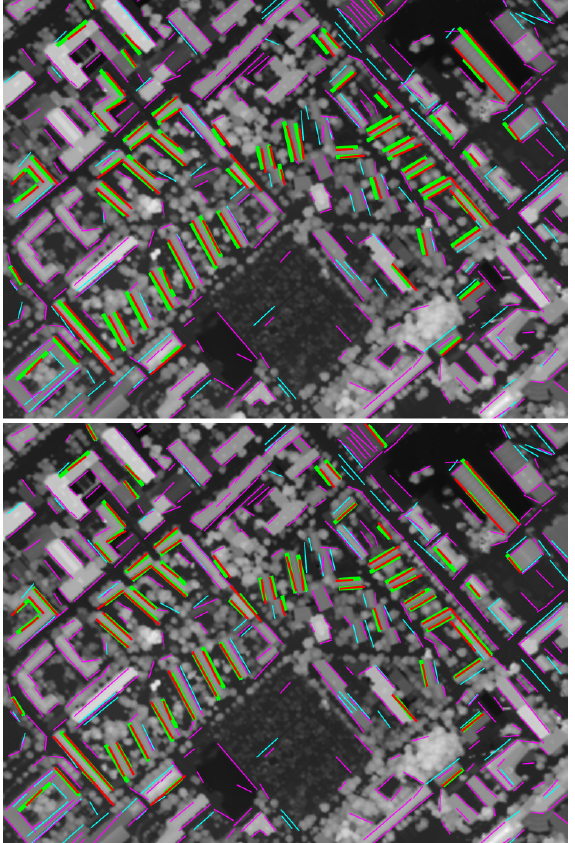
Figure 5: Detected buildings in 3K DSM and HSI, before (top) and after coregistration (bottom). Line colours are analogue to description under Fig. 3.